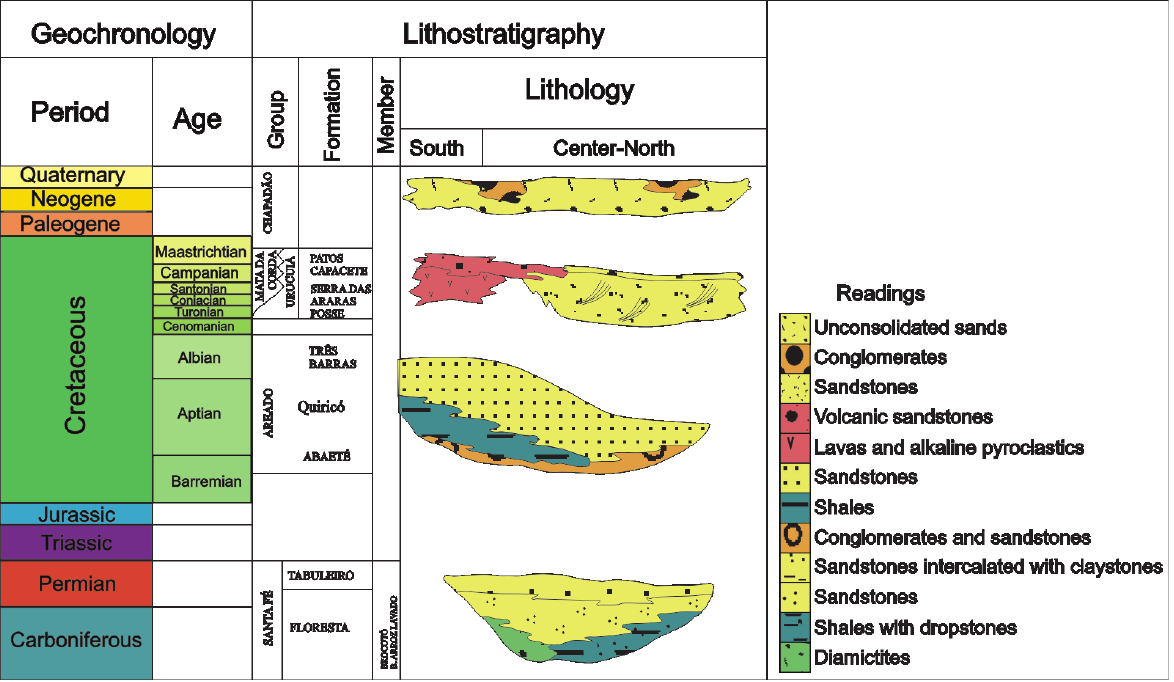
Figure 3. Chronostratigraphic column representing the Phanerozoic sequence of the São Francisco basin (Do Carmo et al. 2004, adapted according to Campos & Dardenne